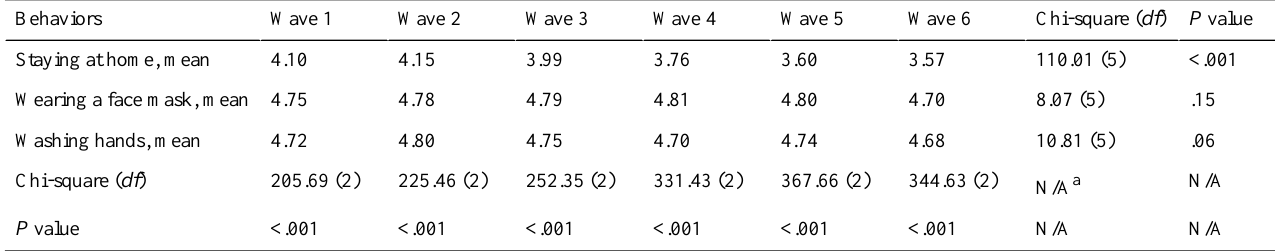
Table 3. Differences in engagement in three protective behaviors across